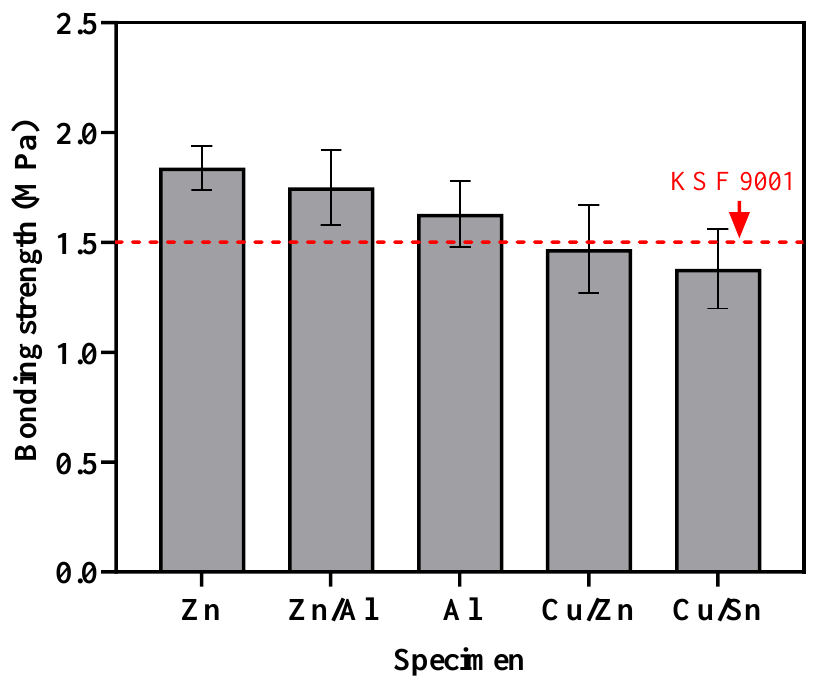
Figure 9. Results of bonding strength tests.